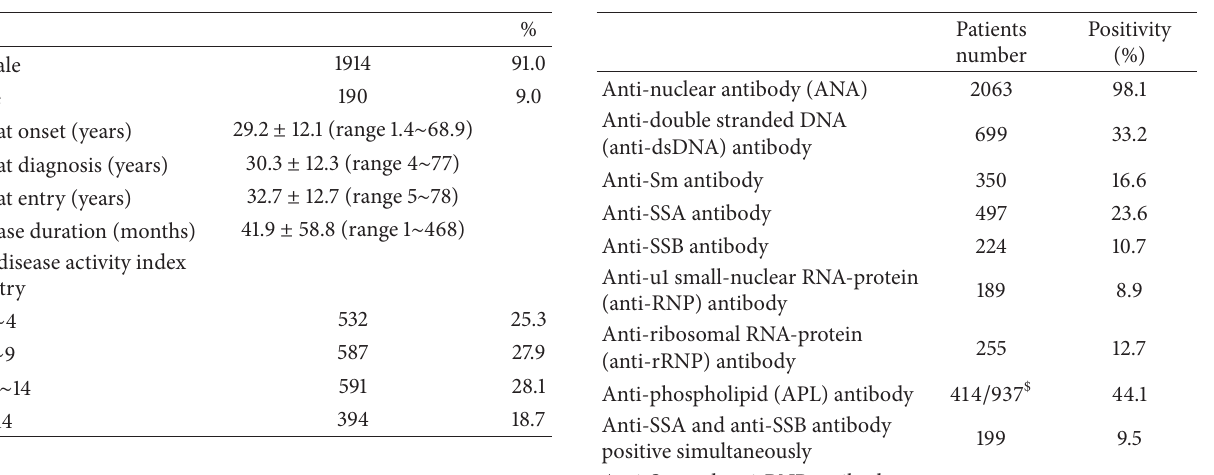
Table 1: The baseline characteristics of 2104 SLE patients from CSTAR cohort study.